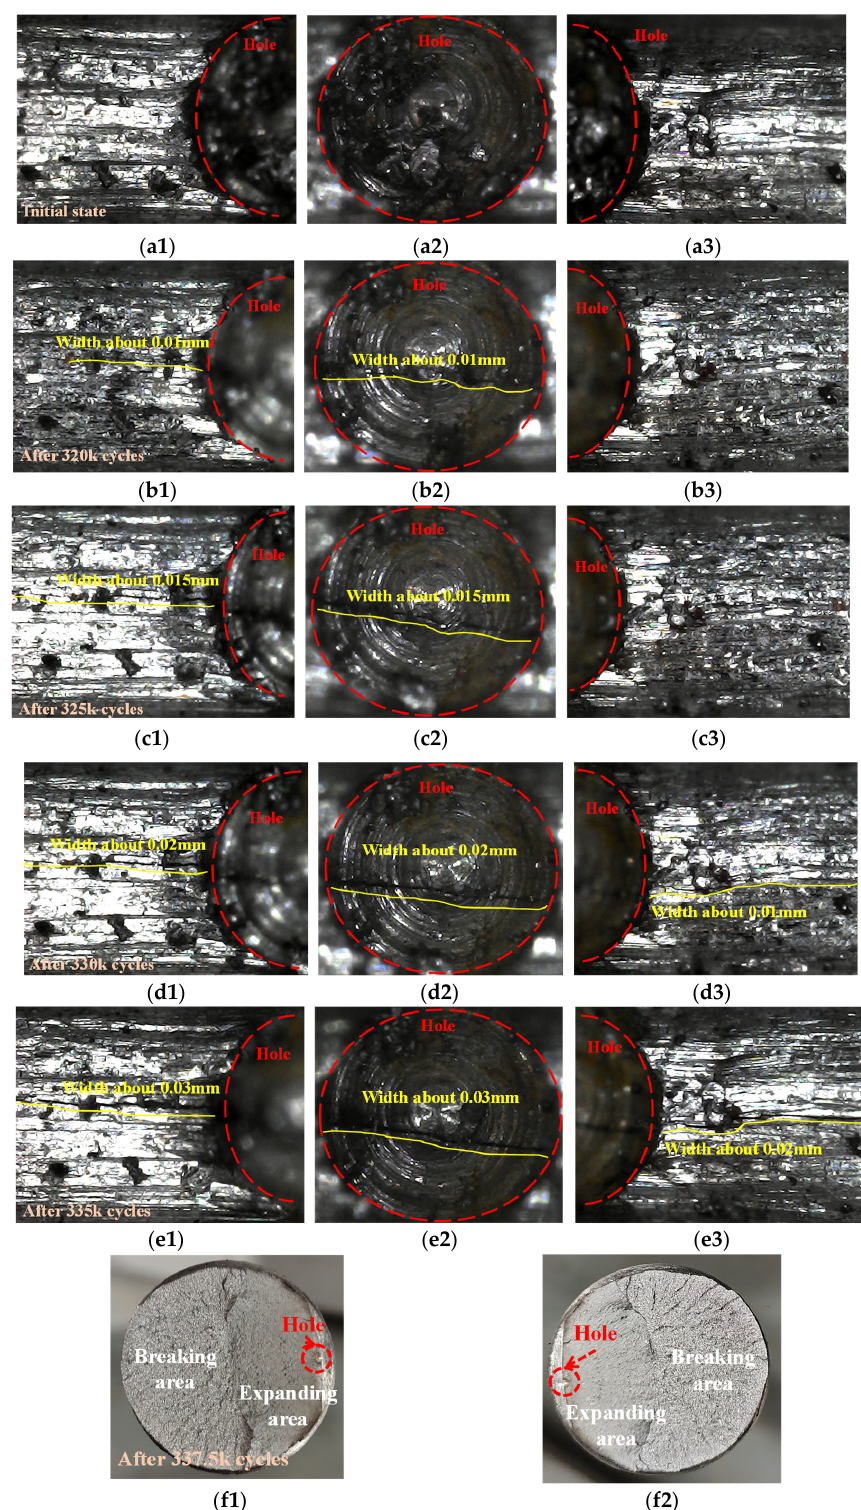
Figure 23. Crack growth and broken at defected cross-section. ( a1 ) left side of hole; ( a2 ) hole bottom; ( a3 ) right side of hole; ( b1 ) left side of hole; ( b2 ) hole bottom; ( b3 ) right side of hole; ( c1 ) left side of hole; ( c2 ) hole bottom; ( c3 ) right side of hole; ( d1 ) left side of hole; ( d2 ) hole bottom; ( d3 ) right side of hole; ( e1 ) left side of hole; ( e2 ) hole bottom; ( e3 ) right side of hole; ( f1 ) Upper broken surface (close to end D); ( f2 ) Lower broken surface (close to end A).